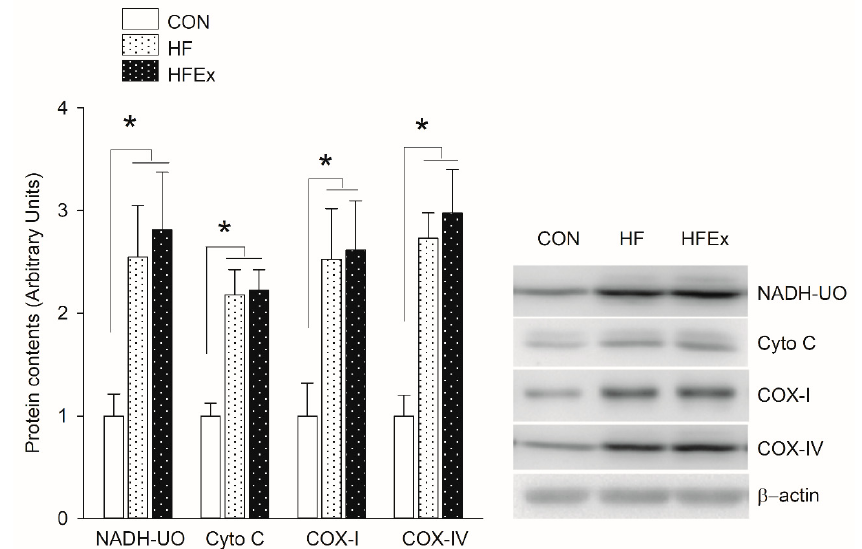
Figure 3. Expression levels of protein involved in mitochondrial electron transport chain in the EDL muscle. Data are presented as means ± SEM. Data was analyzed by one-way ANOVA. * p < 0.05 vs. CON. CON, control; HF, HFD intake; HFEx, high-fat diet with low-intensity endurance exercise; EDL, extensor digitorum longus.